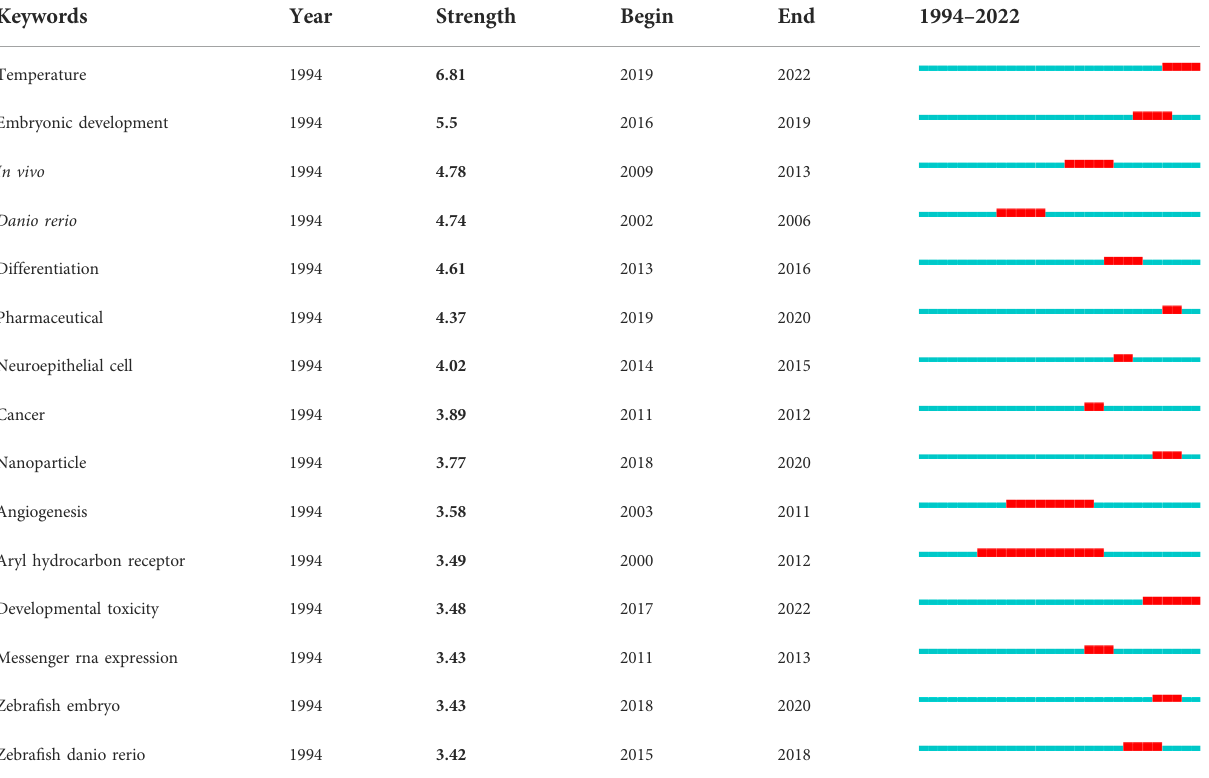
TABLE 11 Fifteen keywords with a citation burst for research on zebra fi sh and climate